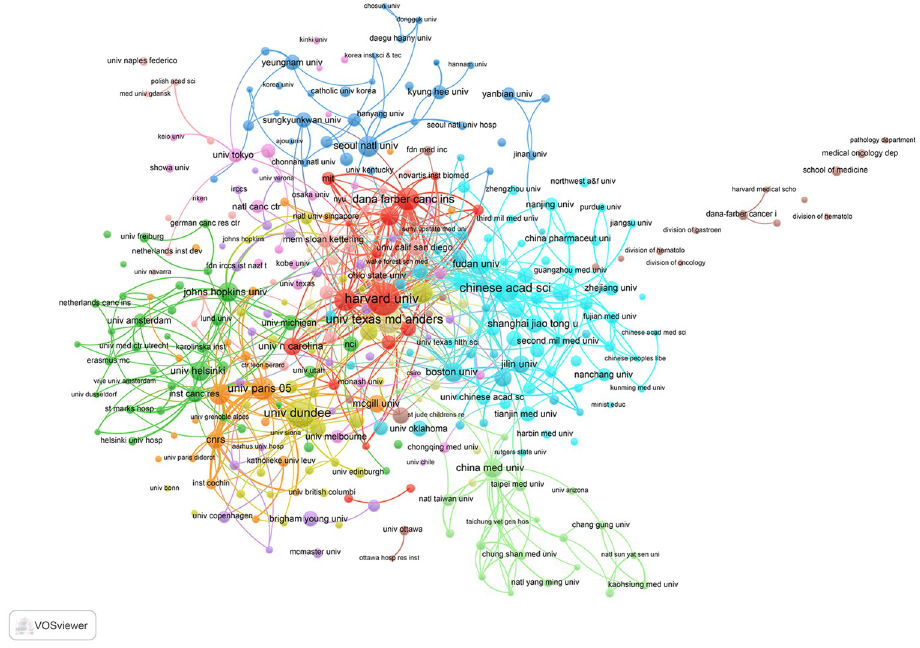
Fig 4. Collaboration network of main